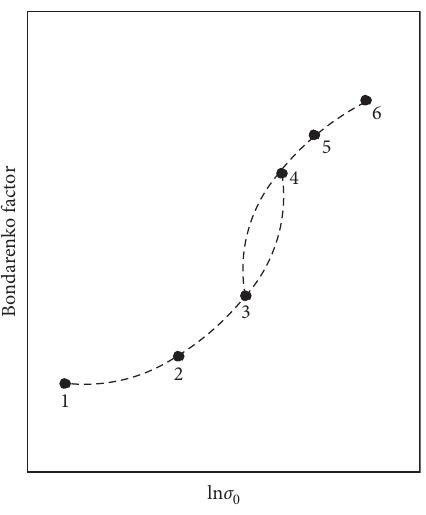
Figure 3: “S-shape” of σ 0 variation of Bondarenko factor. Table 1: VENUS-3 benchmark device material